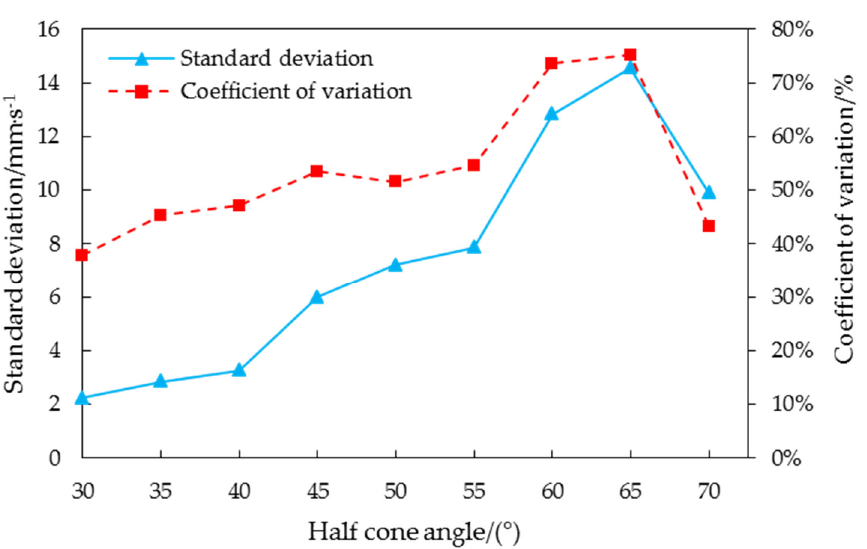
Figure 15. Standard deviation and coefficient of variation of the average velocity in 1 s in the periodic pulsation period with the half cone angle in the range of 30–70°.